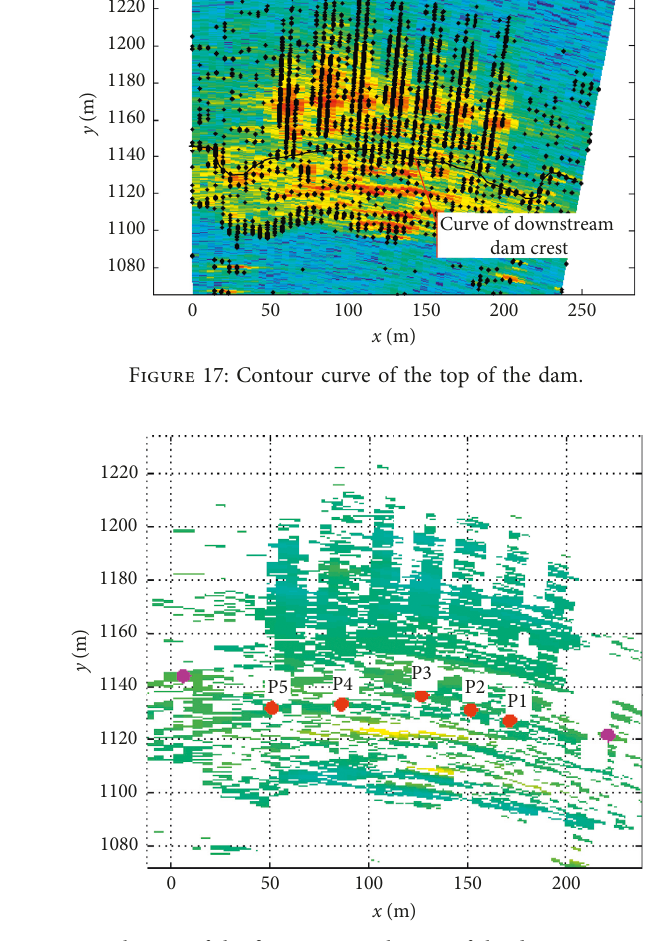
Figure 18: Distribution of the five points at the top of the dam in a GB-SAR